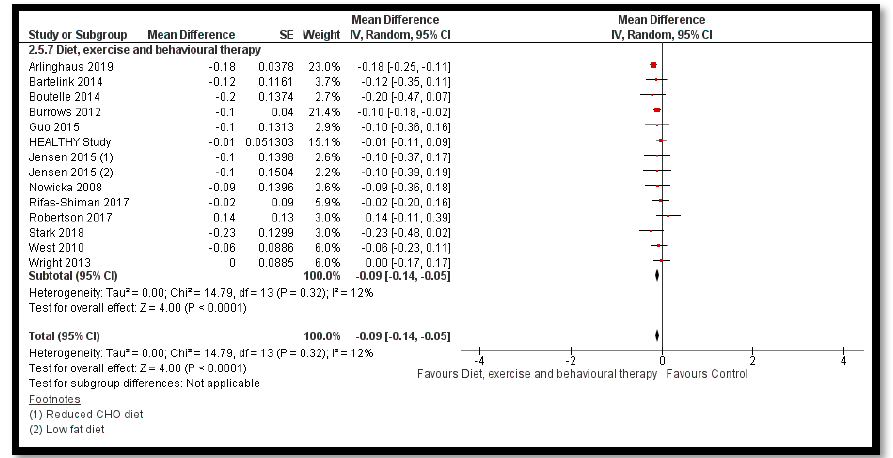
Figure 12. Forest plot for the effect of diet and behavioural therapy interventions for obesity management on body mass index (BMI) z -score.